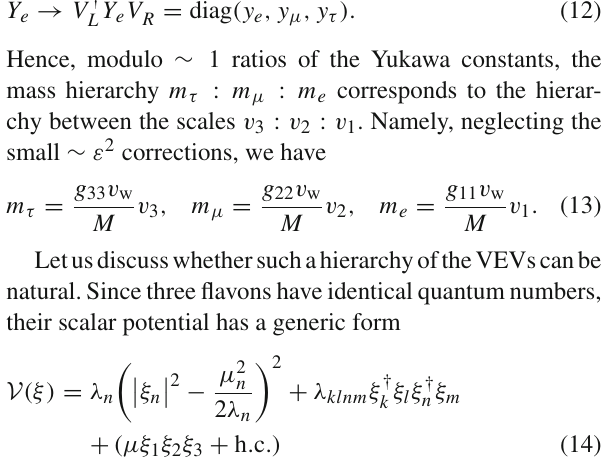
The charged lepton masses then can emerge from the gauge invariant dimension 5